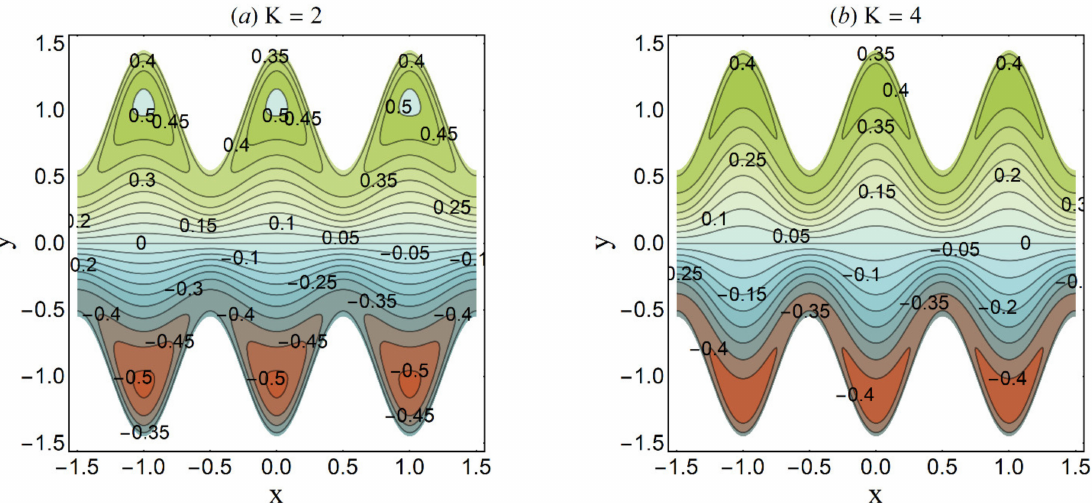
Figure 25. Streamlines for variation in K when n = 0.2 We = 0.05, α = 0.45, ε = 4, β = 0.1, U HS = 2, Ha = 1, Q = 0.4. ( a ) K = 2; ( b ) K = 4.